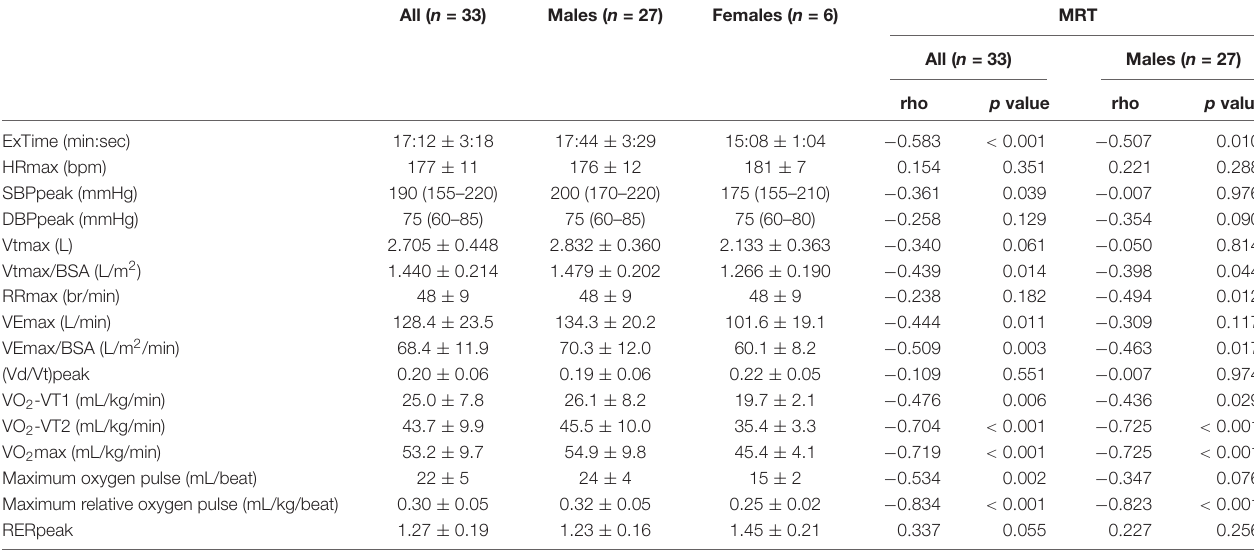
TABLE 2 | Values of parameters of cardiopulmonary exercise testing and their relationship with marathon race time